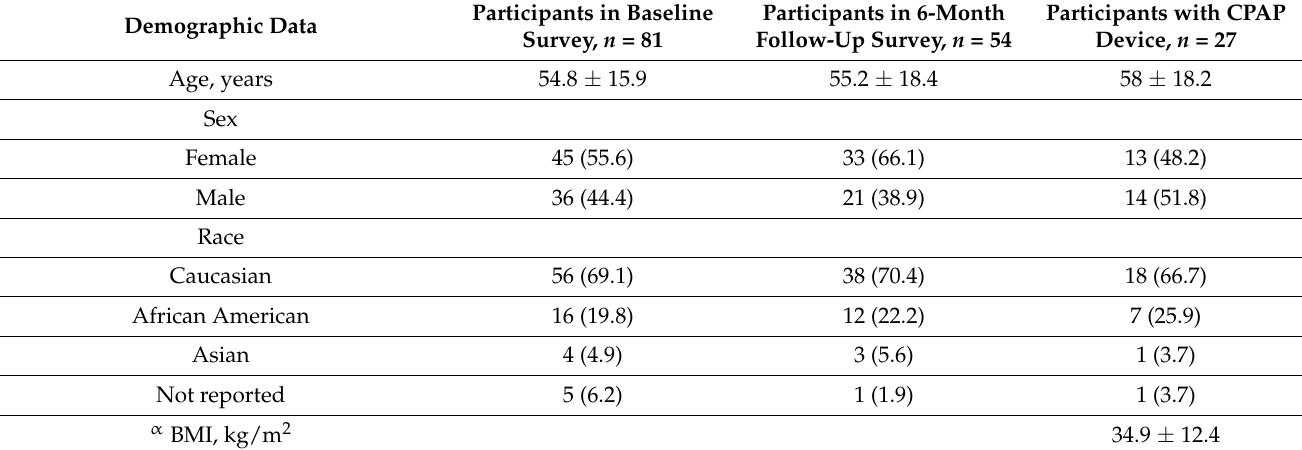
Table 1. Characteristics of